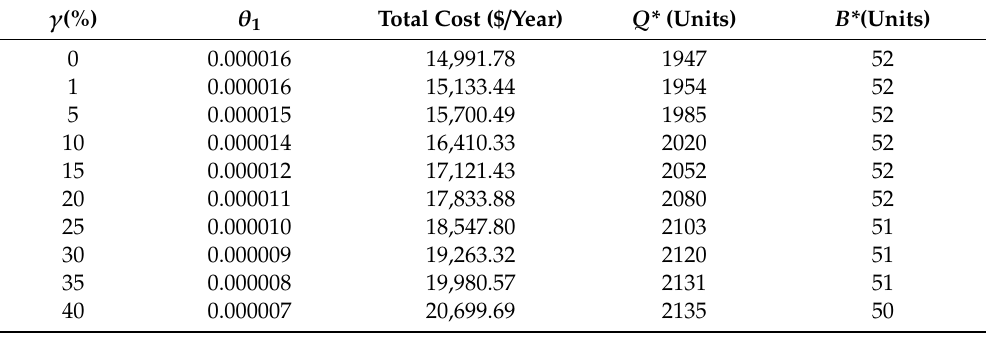
Table 3. Change in optimal lot size and backorder quantity with variation in the defective rate (Example 2).